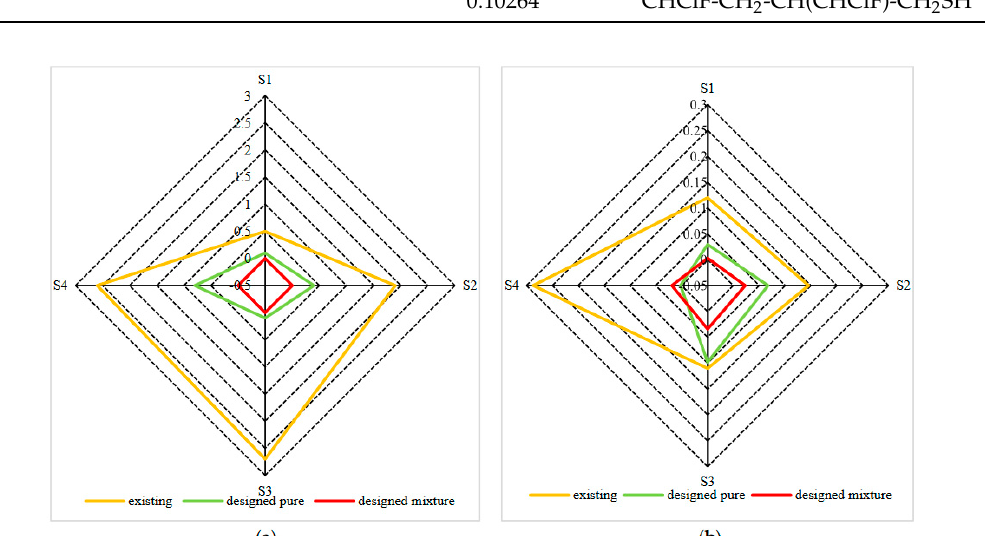
Figure 2. The difference in actual and optimal values ( a ) critical temperature and ( b ) r value.